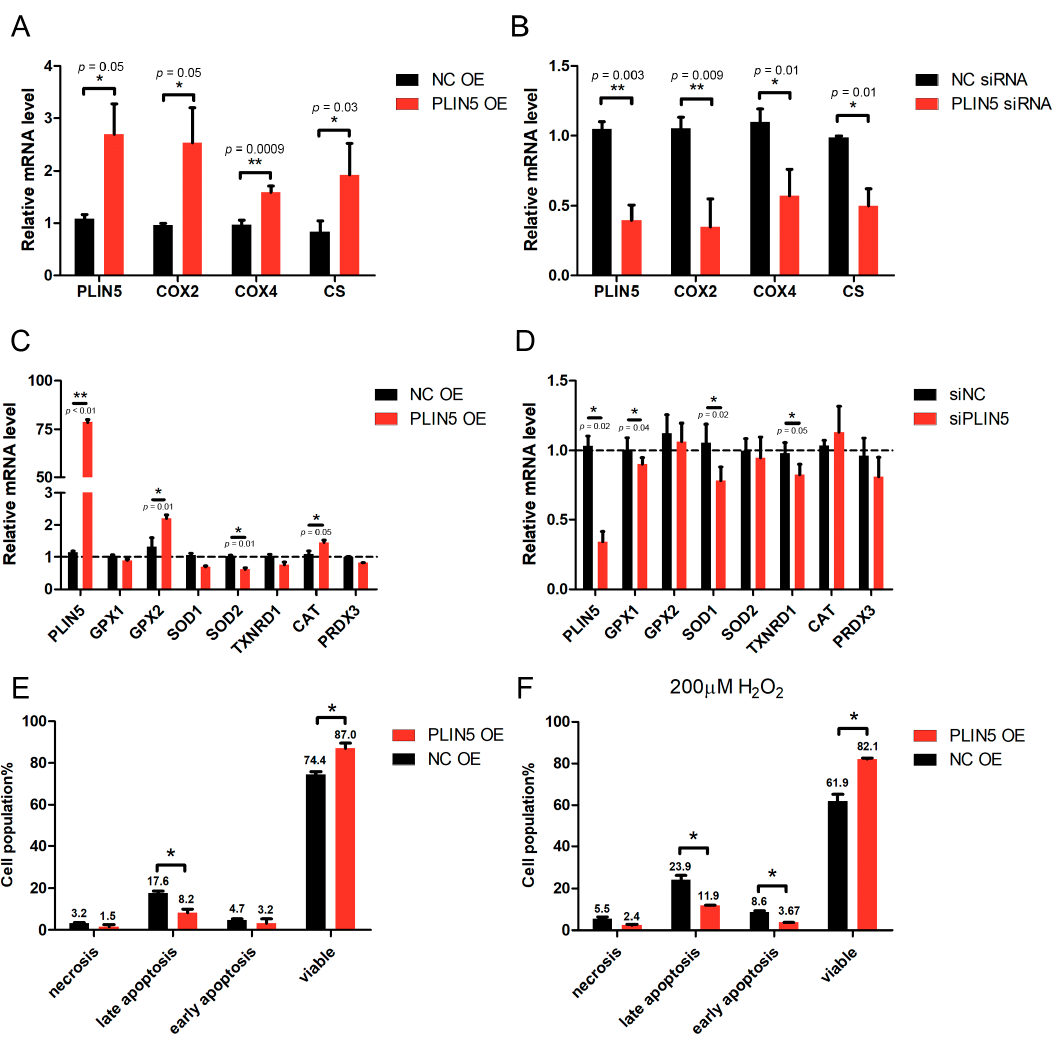
Figure 5. PLIN5 regulated the expression levels of mitochondrial function-related genes and